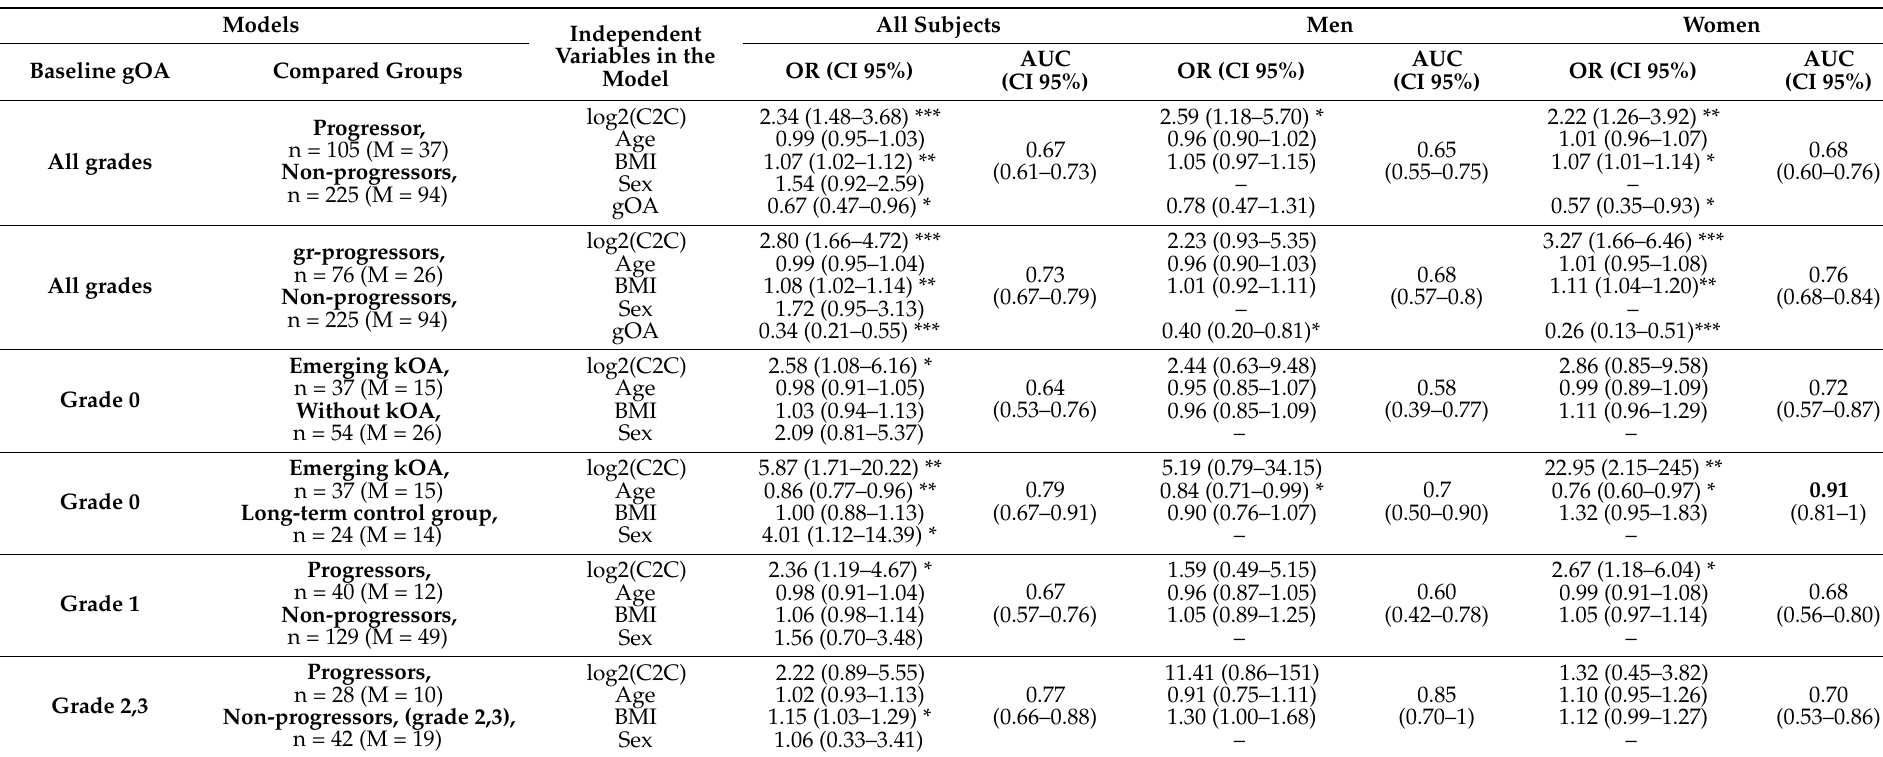
Table 3. Adjusted generalized linear models of uC2C for subject groups with progression in the distinct baseline grades of knee osteoarthritis (gOA), multiple logistic regression